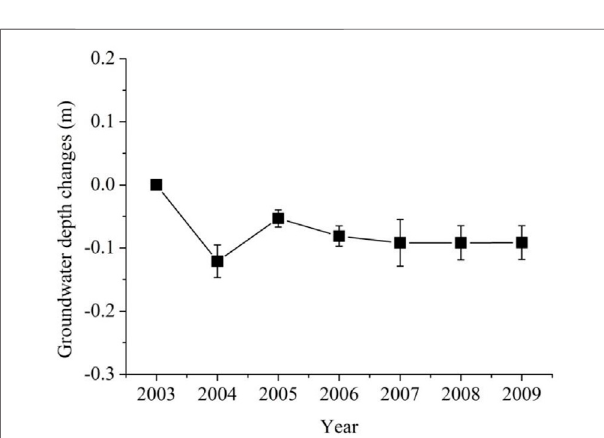
FIGURE 5 | The groundwater dynamics along the highway (Fan et al., 2017), reproduced with data kindly provided by Dr. Fan Jinglong, Chinese Academy of